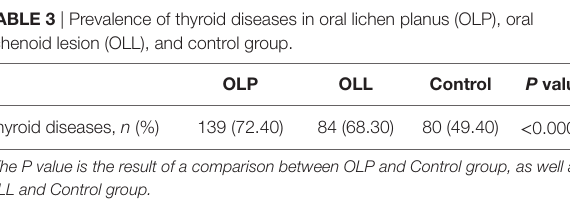
TaBle 4 | Thyroid diseases in oral lichen planus (OLP) and oral lichenoid lesion (OLL) patients and control group by risk factor analysis.